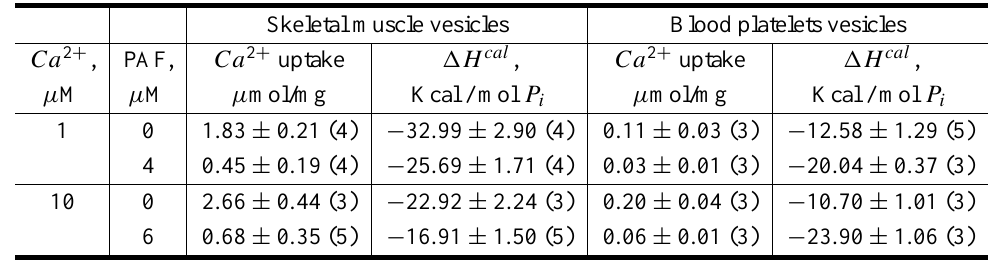
Effect of PAF on the Ca 2 + uptake and (cid:5)H cal of ATP